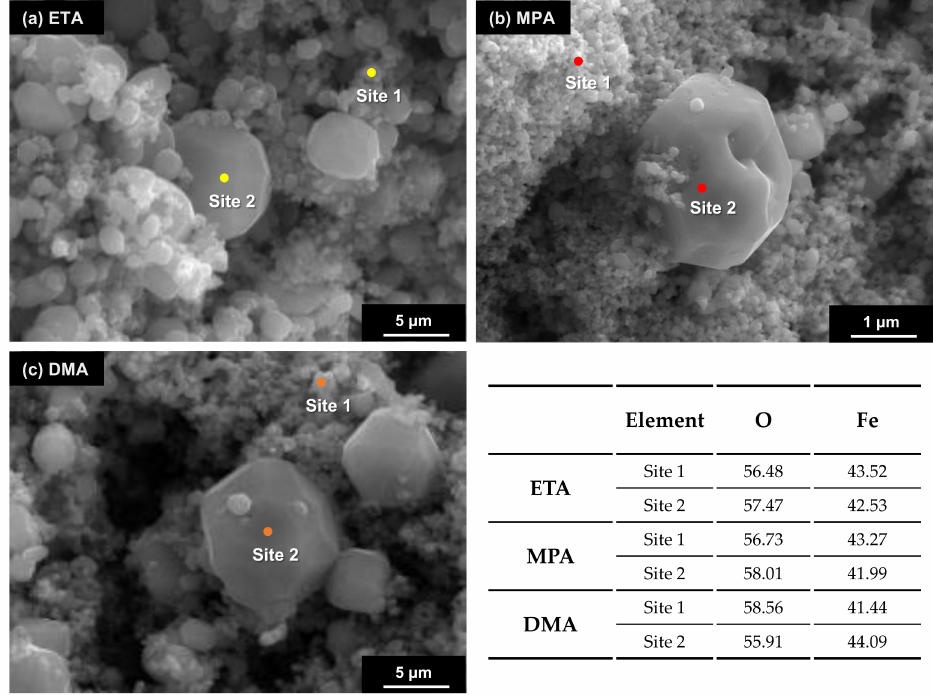
Figure 12. Chemical composition of particles deposited on an Alloy 690TT tube in the test using Three advanced amine, according to SEM-EDS analysis (at.%): ( a ) ETA, ( b ) MPA, and ( c )